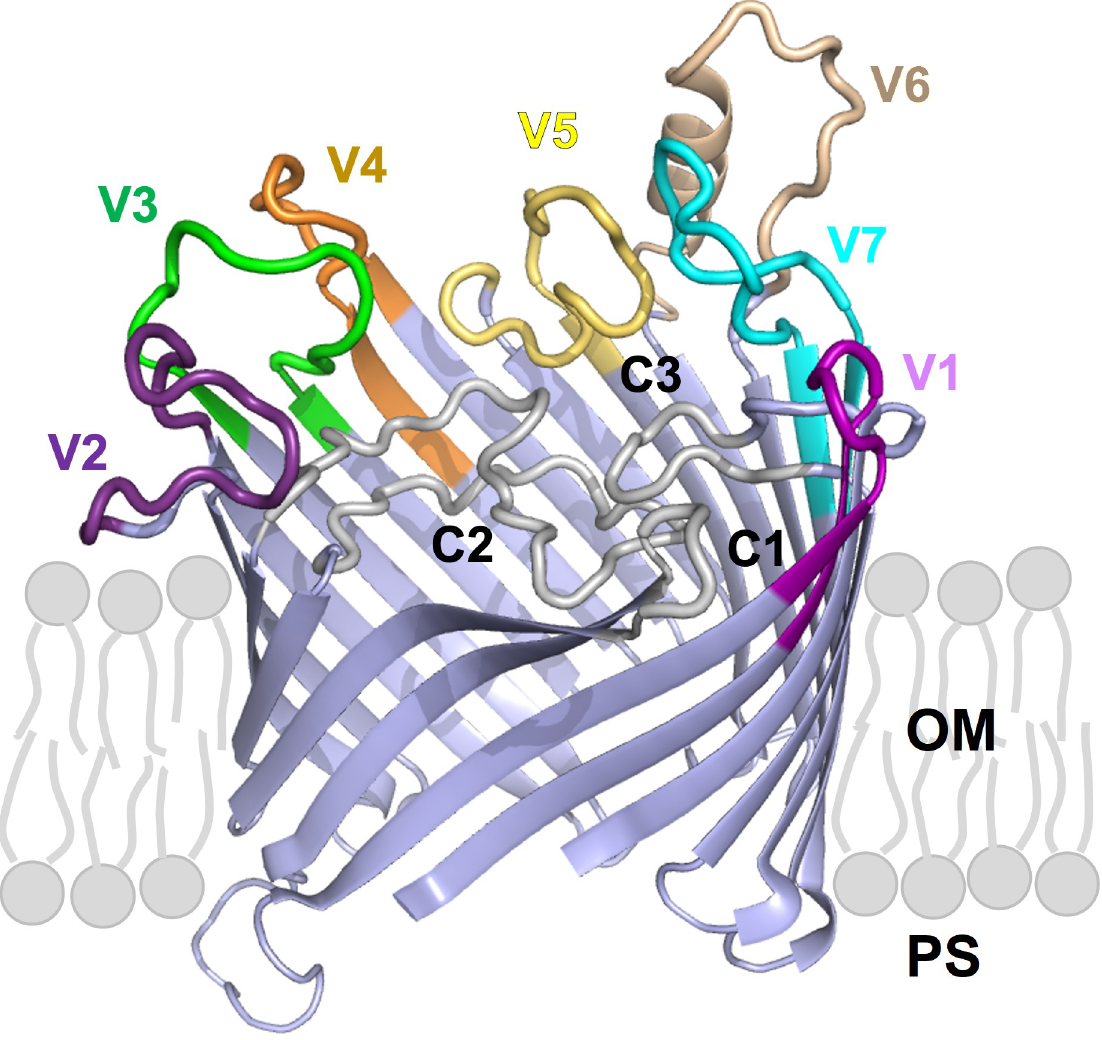
Fig 1. TprK (sequence AIP85979.1) is predicted by AlphaFold2 to fold into a 20-strands beta-barrel structures with 10 surface- exposed loops. Variable loops (V1-V7) are highlighted in colour. Conserved loops (C1-C3) are in white, and β -scaffolding are in light blue. OM: outer membrane; PS: periplasmic